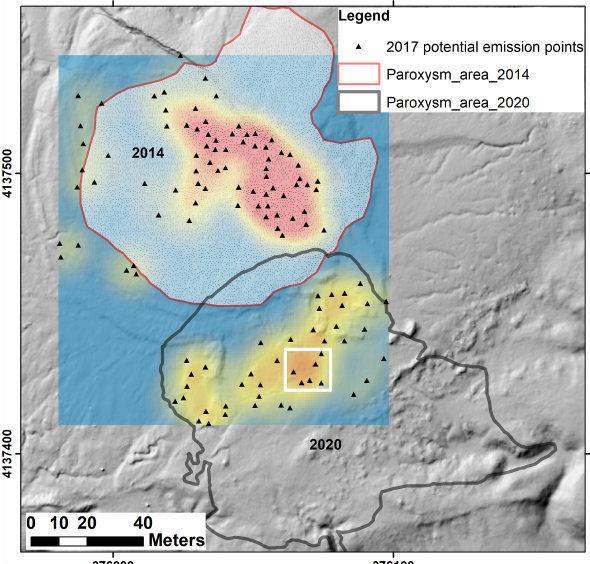
Figure 9. Density maps for the 2017 emission points (red: high den- sity; yellow: low density). The covered surface area for the 2014 and 2020 paroxysms is shown with red and grey lines respectively. In the white square are the 2017 emission points, likely responsible for the new 2020 paroxysm event (source: 2017 DTMs in ArcGIS